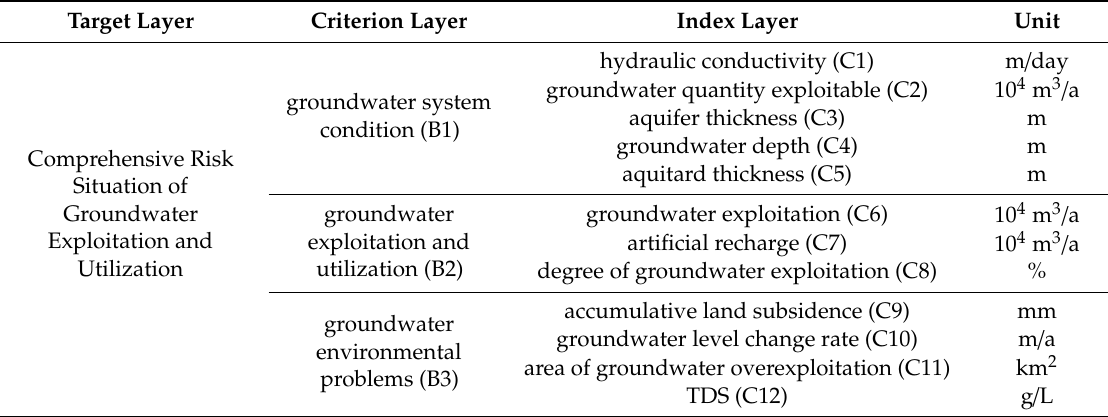
Table 8. Risk evaluation index system for groundwater exploitation and utilization in Shanghai.